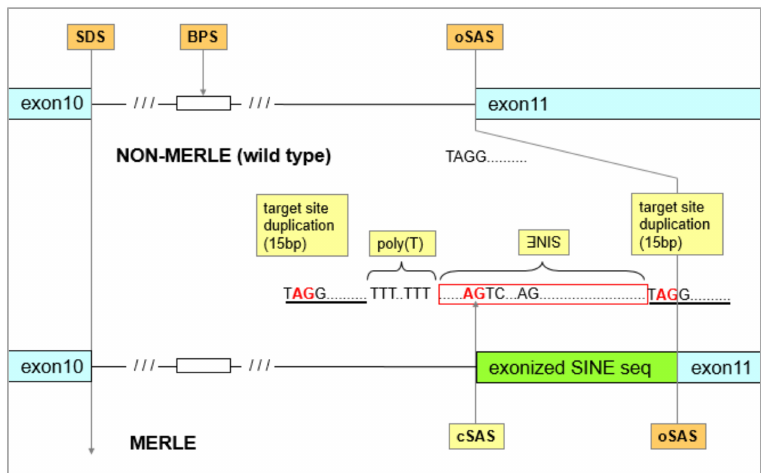
Figure 3. Schematic comparison of the a ff ected region of PMEL locus in non-merle (wild type; top) and merle (bottom) dogs. Color codes: exons (light blue); functional elements of the wild type (light brown); new functional elements introduced by merle-SINE (yellow); exonized sequence (green). Abbreviations: SDS—splice donor site; BPS—branch point; oSAS —original splice site; cSAS—cryptic splice